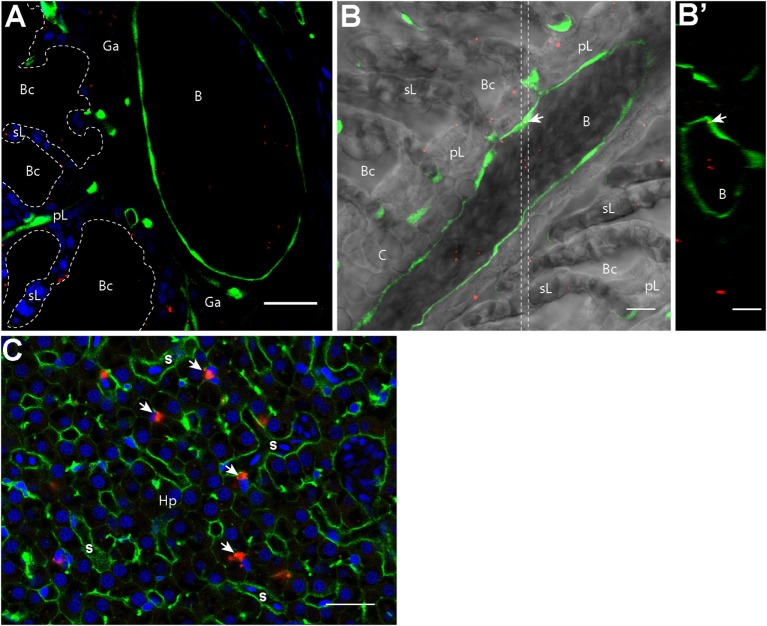
Nanoparticles (NPs) reach the circulatory system and the liver. (A,B′) Representative confocal images of gills from transgenic fli:GFP adults bathed for 24 h in 0.05% red fluorescent NPs. Images were acquired in 40-μm-thick whole-body cryosections, stained with DAPI [blue in (A)]. NPs are found in the lumen of gill arch (A) and gill filament (B) blood vessels, which are delimited by green endothelial cells. NPs were also detected inside endothelial cells [arrow in (B)]. (B′) These observations are confirmed by the orthogonal view realized in the area between the two dotted lines in (B). (C) Representative confocal image of the liver of wild-type adults exposed to 0.01% red fluorescent NPs. Images were acquired in 40-μm-thick whole-body cryosections, stained with phalloidin (green) and DAPI (blue). NPs are highly concentrated in cells close to sinusoids (s) and displaying an oblong nucleus (arrows). pL, primary lamellae; sL, secondary lamellae; Bc, branchial cavity; B, blood vessel; Ga, gill arch; C, cartilage; Hp, hepatocytes. Scale bar: 10 μm (B,B′), 20 μm (A,C).